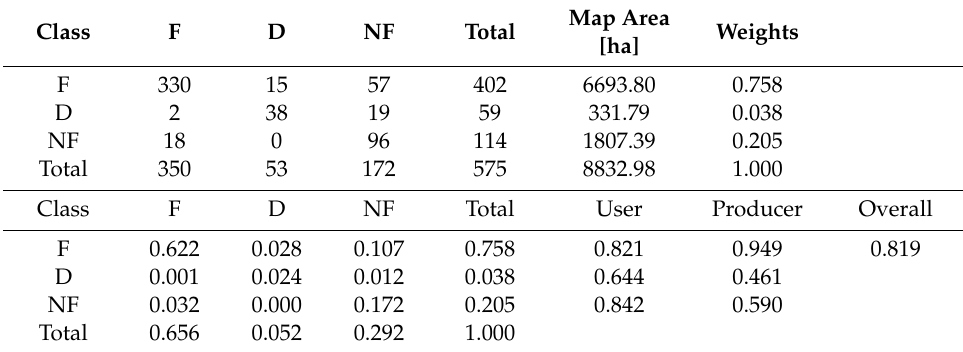
Table A3. “S1 Only” Peru disturbance map